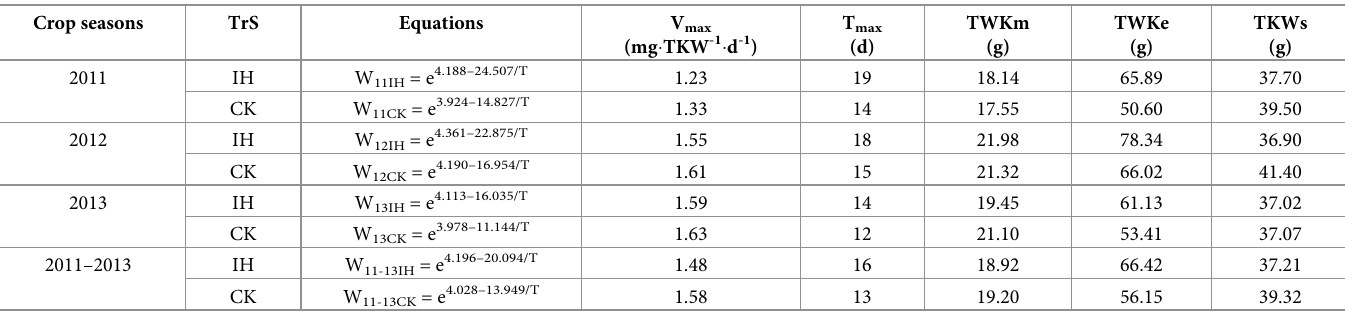
Table 5. The TKW equation and max